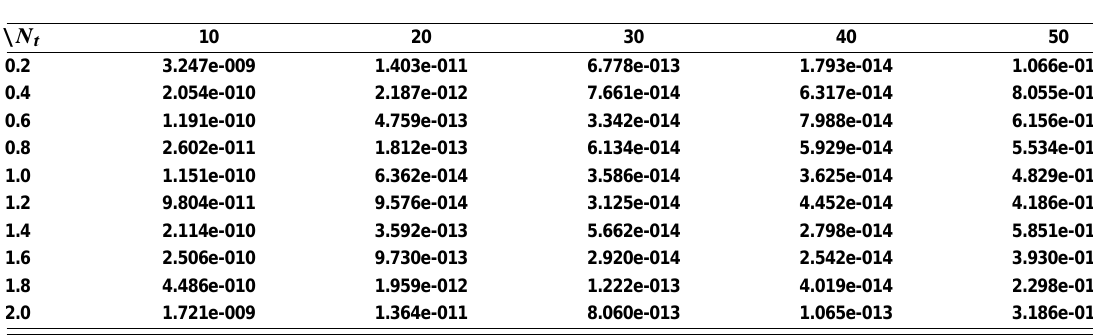
Table 3. Maximum errors E N for Burgers-Huxley equation when ˛ D ˇ D 1 and (cid:13) D 0:5 using N x D 30